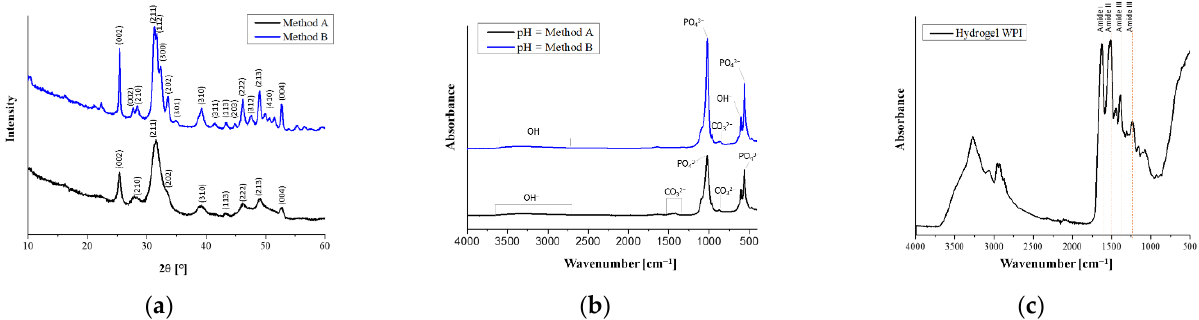
Figure 1. ( a ) XRD diffractograms of hydroxyapatite obtained by methods A and B; ( b ) FTIR spectra of hydroxyapatite obtained by methods A and B; ( c ) FT-IR spectra of WPI hydrogel.